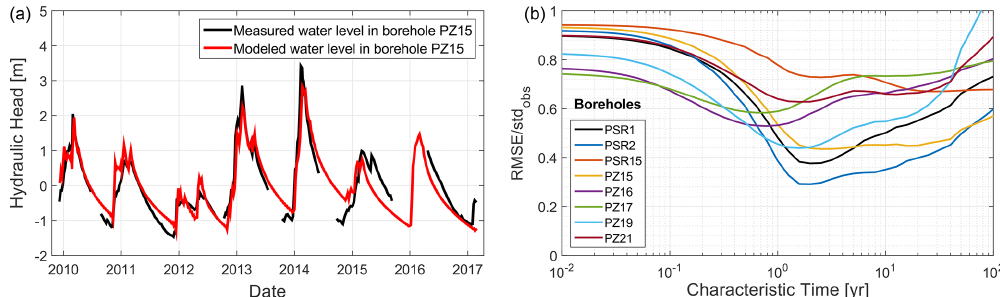
Figure 7. (a) Comparison between best modeled and observed water table fluctuations at borehole PZ15 in Guidel. Hydraulic parameters correspond to best parameters (lowest RMSE regarding water table fluctuations). (b) Evolution of the minimal normalized RMSE as a function of characteristic time, which is a combination of three parameters (storage coefficient, transmissivity and aquifer length), for Guidel